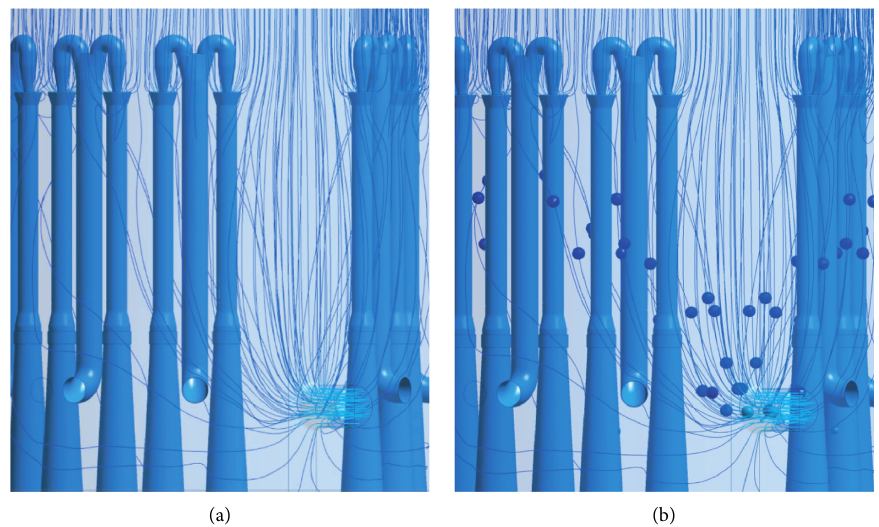
Figure 9: Fluid streamlines around the jet pumps in the cylindrical annular region of a BWR.